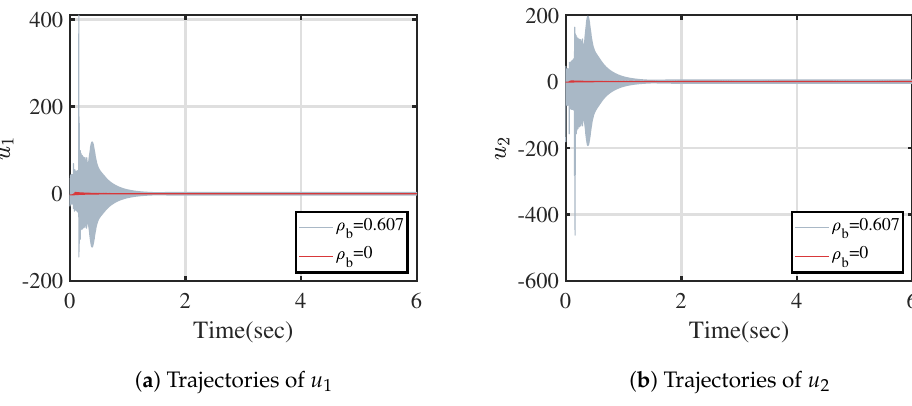
Figure 9. The state variable performance of the system controlled by cSMC in the cases of ρ b = 0.607 (Gray solid line) and ρ b = 0 (Red solid line).